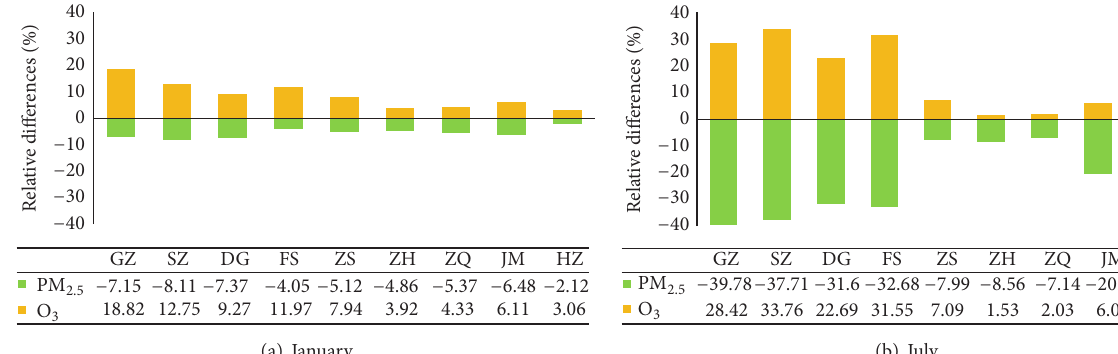
Figure 10: Relative differences (%) of O 3 and PM 2.5 between the GLC2009 case and the GLC2000 case in the nine cities of PRD.